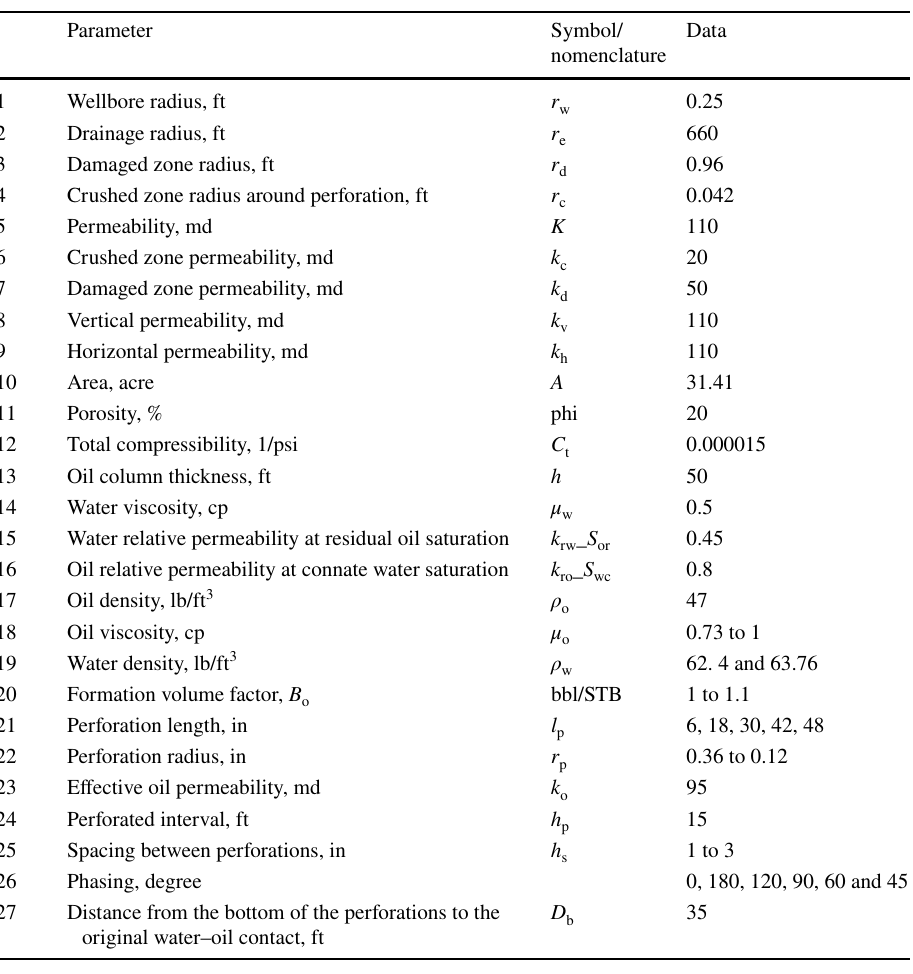
Table 3 Input reservoir data, well, fluids and perforation